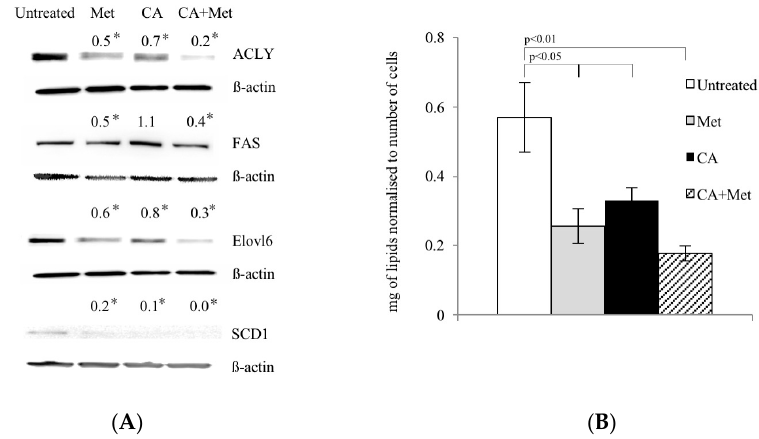
Figure 4. Met decreases expression of lipogenic genes ( A ) and unsaturated FA content ( B ) in human cervical carcinoma HTB-34 cells. Total cell lysates were subjected to SDS-PAGE followed by Western blot analysis and chemiluminescent detection (band intensities were quantified by densitometry analysis; the details described in Material and Methods, * p < 0.05 vs. untreated control). Note that co-treatment of cells with Met and CA for 24 h restrains the expression of ACLY, FASN, ELOVL6, and SCD1 ( A ) and significantly decreases unsaturated FA content in cancer cells, as measured by spectrophotometric assay. Data shown here are from a representative experiment repeated three times with similar results and presented as mean values ± SD ( B ).